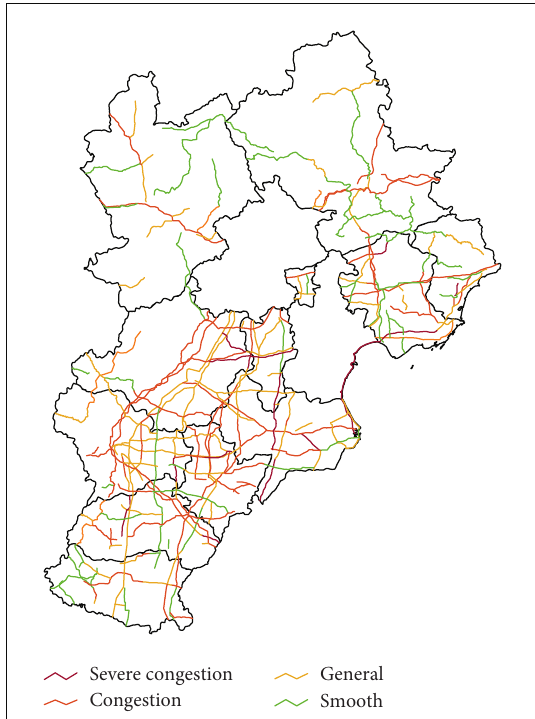
Figure 6: The real average traffic state of each highway.